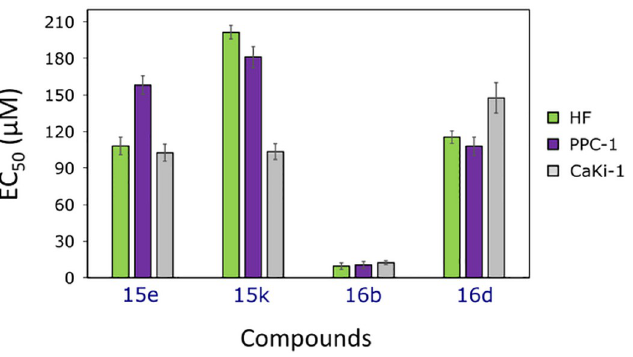
Fig 3. EC 50 values of the most active sulfamethoxazole derivatives 15e, 15k, 16b, and 16d, obtained by MTT assay, after 72 hours of incubation, n = 3.